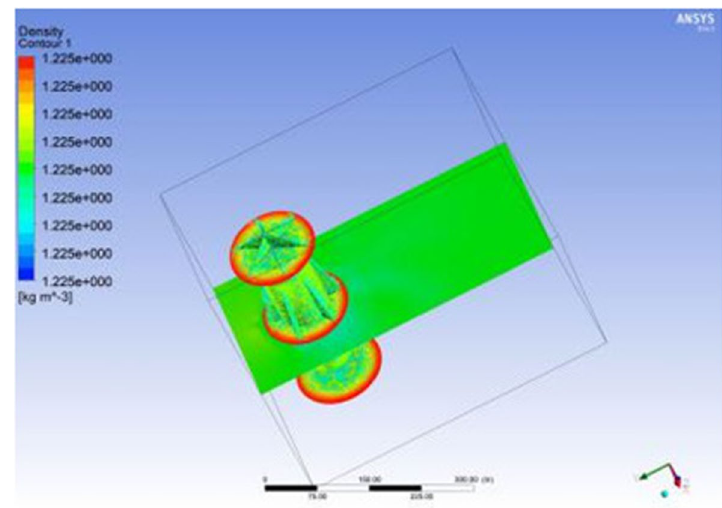
Fig. 4 Balloon density distribution in the XOY plane‑wind speed 10 m/s and wind direction 0° (ANSYS Fluent 12.0 2009; Vasilescu and Dinu 2020)